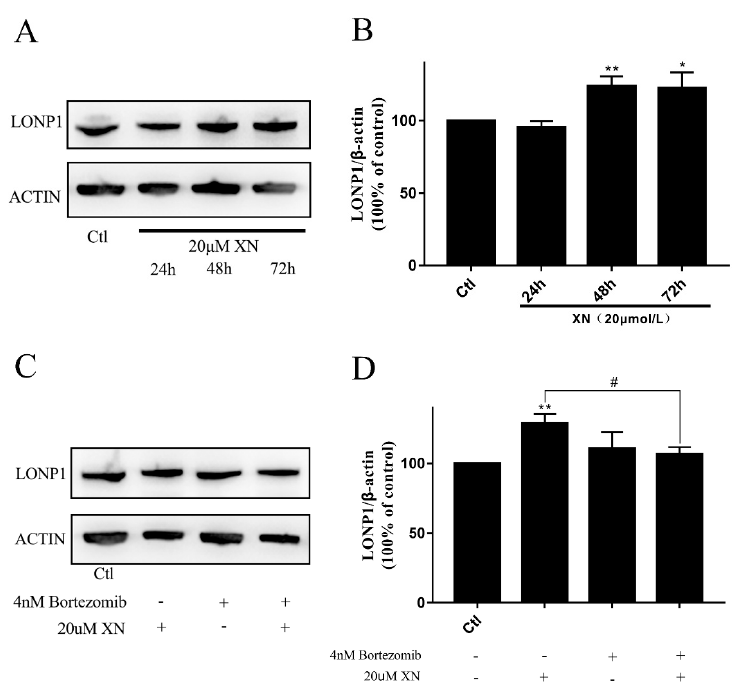
Figure 11. Effect of XN (20 uM) on the level of LONP1 protein with or without bortezomib. ( A , B ) Cells were treated with XN for 24, 48, and 72 h, and then protein expression of LONP1 was determined by Western blot analysis. ( C , D ) The C6 cells were pretreated with 4 nM bortezomib for 1.5 h before the co-treatment with XN for another 48 h, and then protein expression of LONP1 was determined by Western blot analysis. All data presented are the mean ± SEM from three independent experiments. * p < 0.05, ** p < 0.01 vs. control groups. # p < 0.05.vs the XN treated